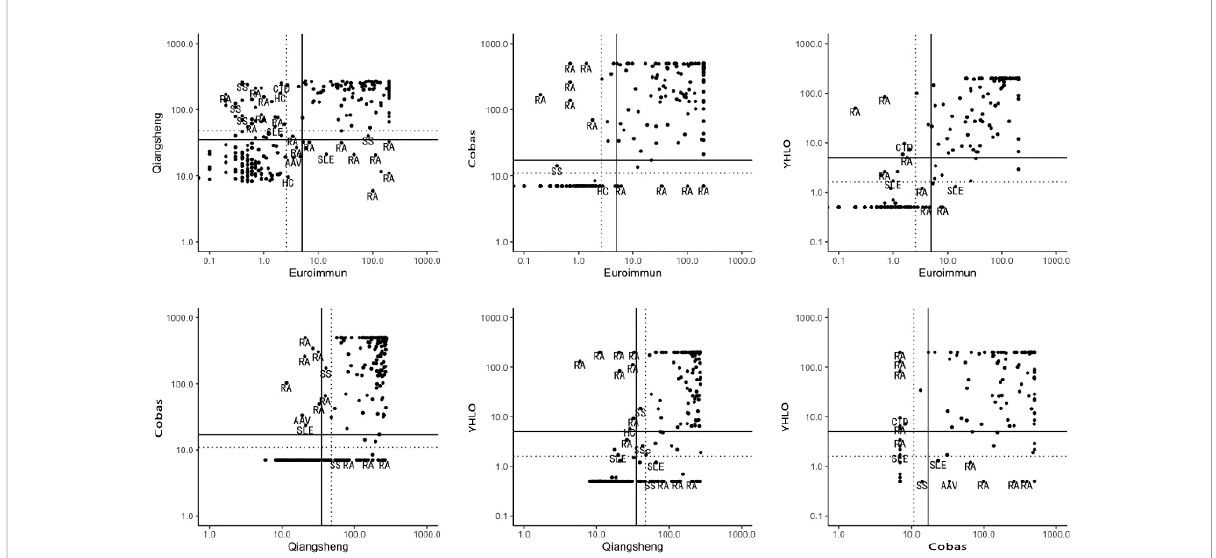
Figure 1 Discrepant results between assays and their clinical diagnoses. Solid lines: manufacturers ’ cut-off values; broken lines: optimal cut-off. RA, rheumatoid arthritis; SLE, systemic lupus erythematosus; SS, Sjögren ’ s syndrome; CTD, connective tissue disease; SSc, systemic scleroderma; HC, healthy person; AAV, ANCA-associated